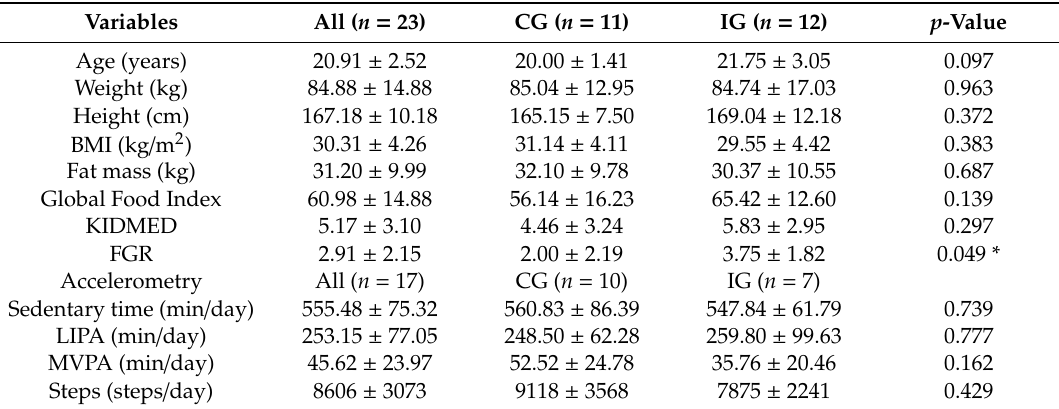
Table 1. Baseline characteristics of